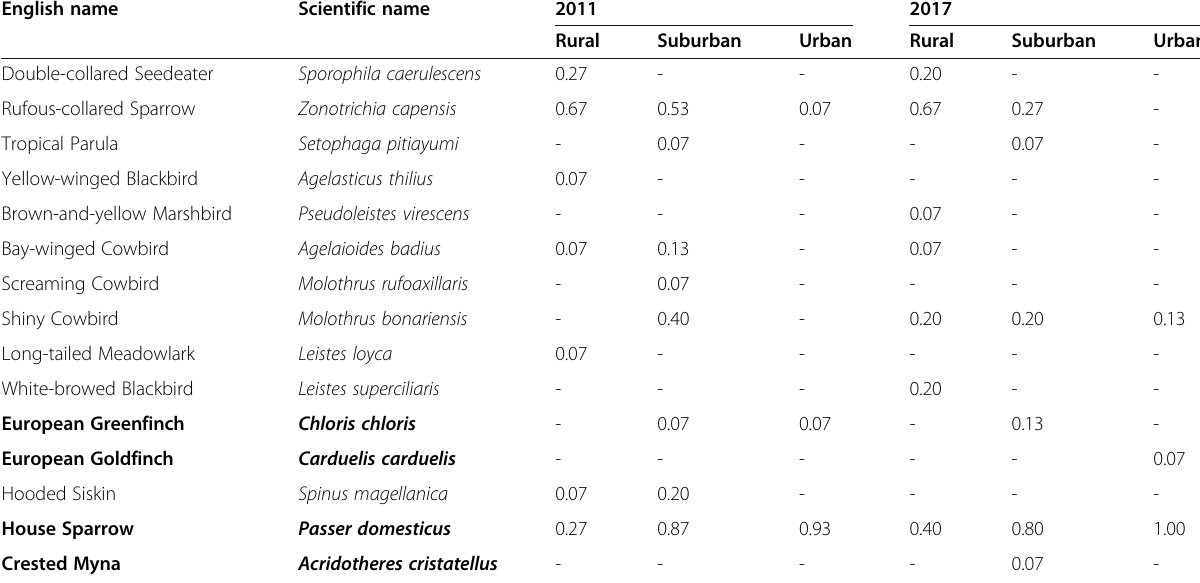
Table 1 Species frequencies (proportion of transects occupied) along the three rural-urban gradients during 2011 and 2017 in central Argentina (Continued)